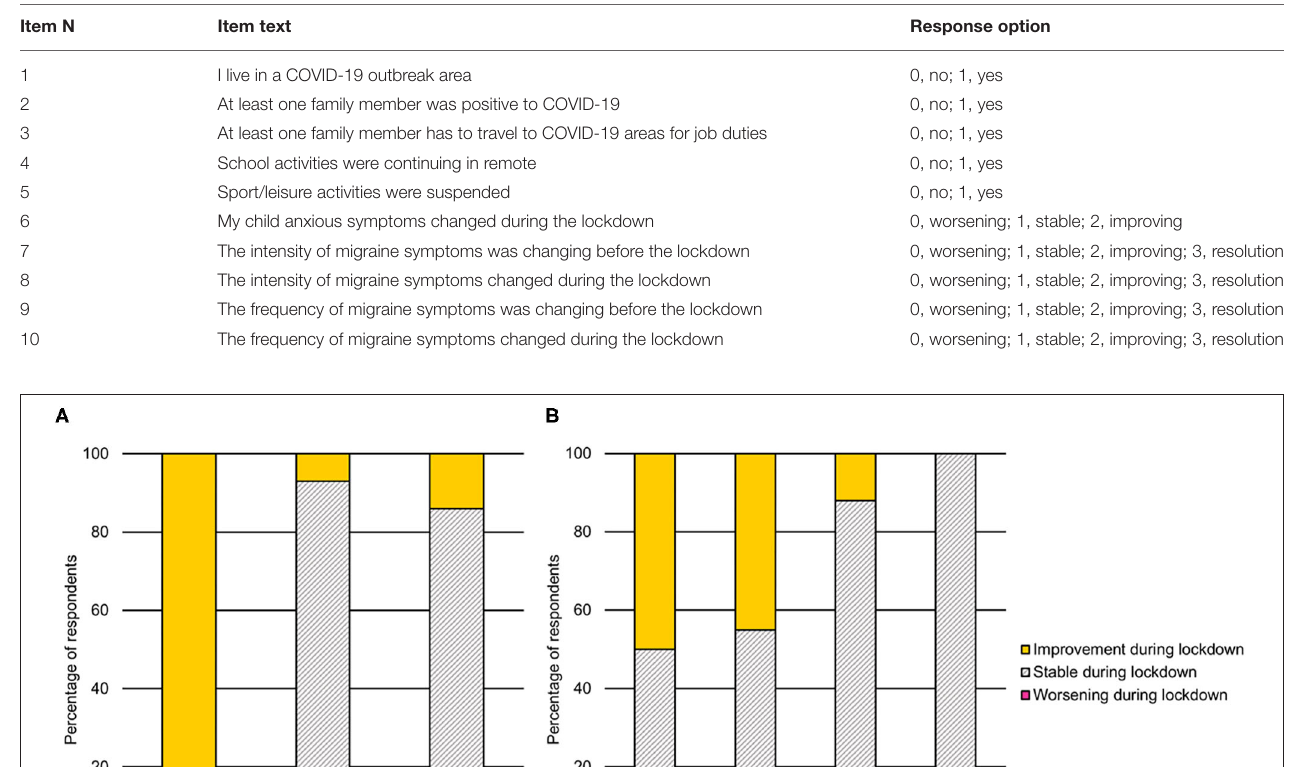
TABLE 1 | Survey structure and items description.